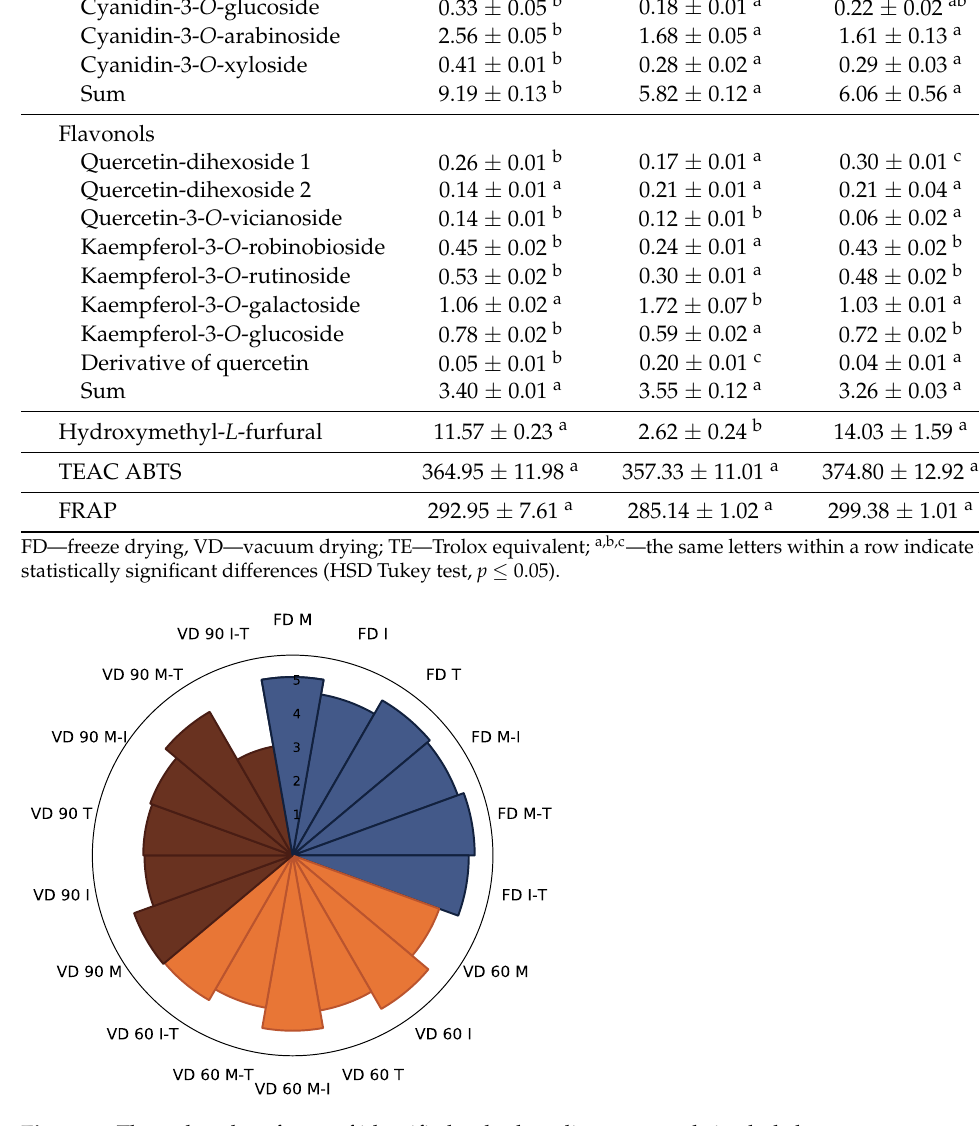
Figure 2. The radar plot of sum of identified polyphenolic compounds in chokeberry pomace extract powders gained with addition of maltodextrin (M), inulin (I), trehalose (T), maltodextrin—inulin (M—I), maltodextrin—trehalose (M—T) and inulin—trehalose (I—T) by freeze drying (FD) and vacuum drying at 60 °C (VD 60) and 90 °C (VD 90) ( n = 2) (g/100 g db). The reverse effect was noted in the case of powders gained after the application of vacuum drying at 60 °C: the addition of inulin resulted in the highest retention of these constituents. Among the powders gained after vacuum drying at 90 °C, the highest reten- tion of the sum of polyphenolics was indicated in the samples obtained after the addition of M and M-T (Figure 2). A statistically significantly lower content of polyphenols was noted when I-T was applied for drying (Table S1). Previously, an influence on the reten- tion of polyphenolics during application of different drying techniques and selected types of carriers was noted for blackcurrant [14] and chokeberry [12]. Going into the details, the percentage share of phenolic acids, anthocyanins, and fla- vonols in the powders obtained by the selected drying techniques was as follows: 42.9%, 41.2%, and 15.9% for freeze-dried samples; 44%, 37.8%, and 18.2% for vacuum-dried sam- ples at 60 °C; and 47.9%, 31.1%, and 21% for vacuum-dried samples at 90 °C. In order to follow these changes, each group of polyphenolics was examined (Table S2). Similar to chokeberry juice powders [12], the dominant identified group of polyphe- nolics present in the controls and powders made with the addition of carriers consisted of phenolic acids [49], among which chlorogenic (50.9% of total phenolic acids), neochloro- genic (47.9% of total phenolic acids), and cryptochlorogenic (1.2% of total phenolic acids) acids were quantified (Table 2 and (Table S2). In comparison, Sójka et al. [46] identified only chlorogenic and neochlorogenic acids in chokeberry pomace dried at 70 °C. In the current study, the content of phenolic acids was the highest in the control samples gained after freeze and vacuum drying at 90 °C, whereas the application of VD at 60 °C resulted, on average, in a 33% lower content of these constituents (Table 2). When the addition of selected carriers was concerned, the average content of the sum of phenolic acids was at a similar level, regardless of the drying technique and parameters applied (Figure 3a–d). There were no statistically significant differences noted between samples gained with the addition of M, I, T, M-I, M-T, and I-T after freeze and vacuum drying at 60 °C. Vacuum drying at 90 °C caused significant changes in the content of phenolic acids (Table S2). The